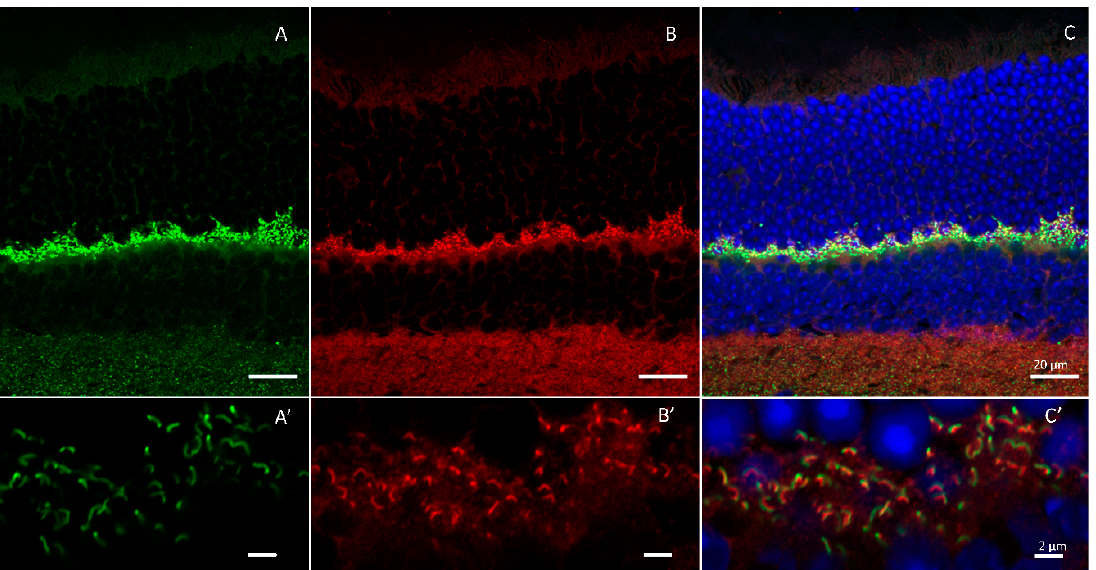
muscle weakening and joint hyperflexibility resulting in severely reduced mobility in early childhood and death by middle age. In addition to progressive muscle wasting, a large subset of MD sufferers also experience cognitive delays and visual dysfunction substantiated by negative ERGs [99–106]. There are multiple types of the disorder, but the most commonly known are Duchenne muscular dystrophy (DMD) (1/3500) and the less severe Becker muscular dystrophy (BMD) (1/30000), which are both X-linked disor- ders [107,108]. Many of the proteins that comprise the ribbon are also present at conven- tional nonribbon-type synapses; therefore, dysfunction of proteins at conventional syn-